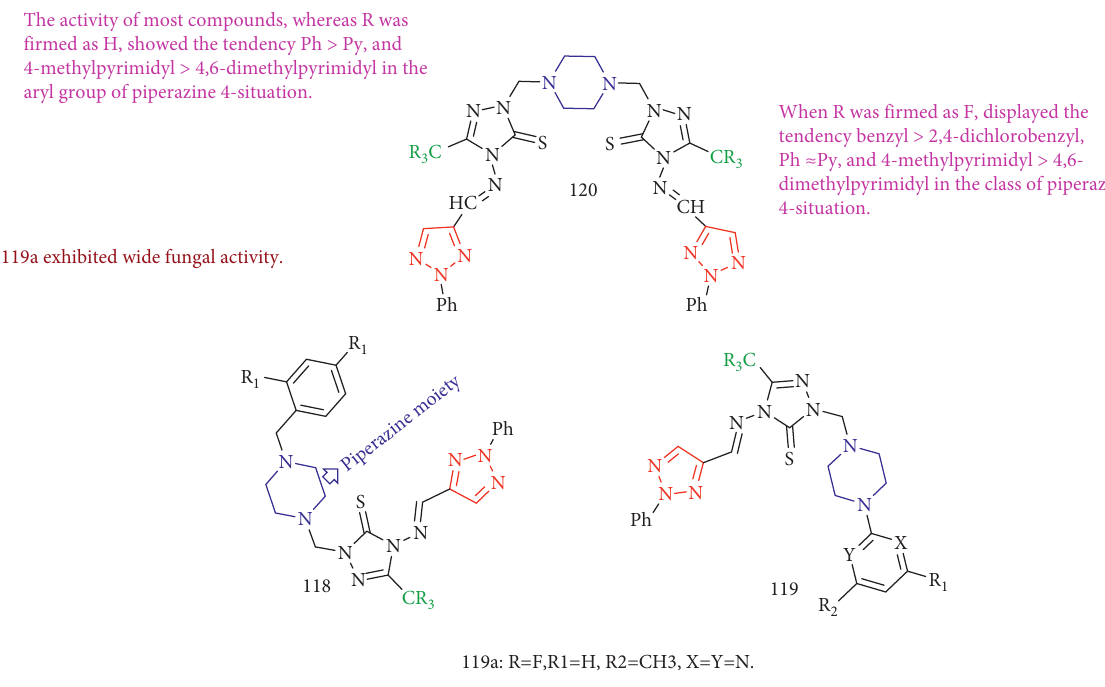
Figure 57: Chemical structure of novel 1,2,4-triazole thione derivatives containing 1,2,3-triazole and substituted piperazine